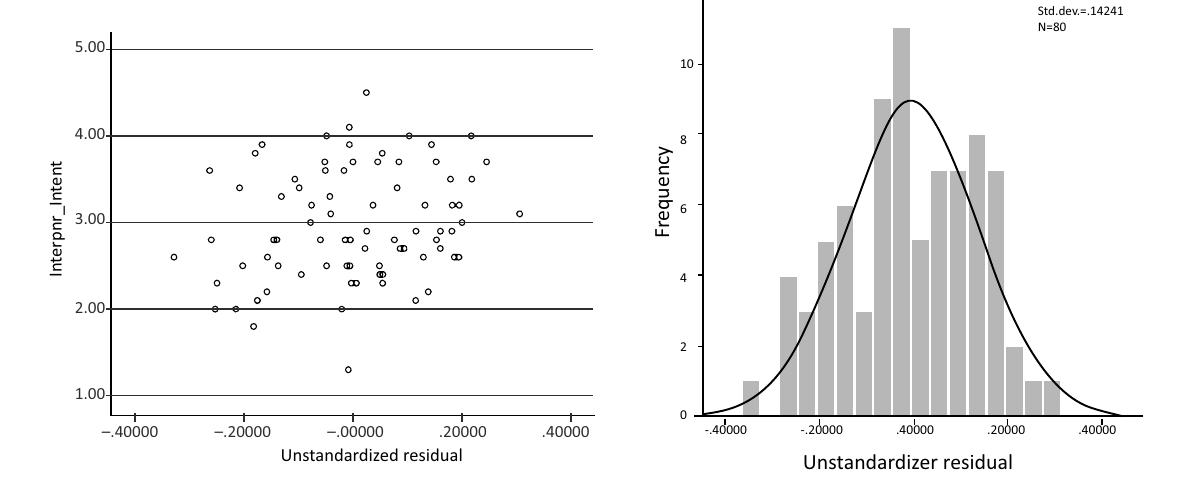
Figure 5. Scatter Plot Figure 6. Normality Distribution Curve